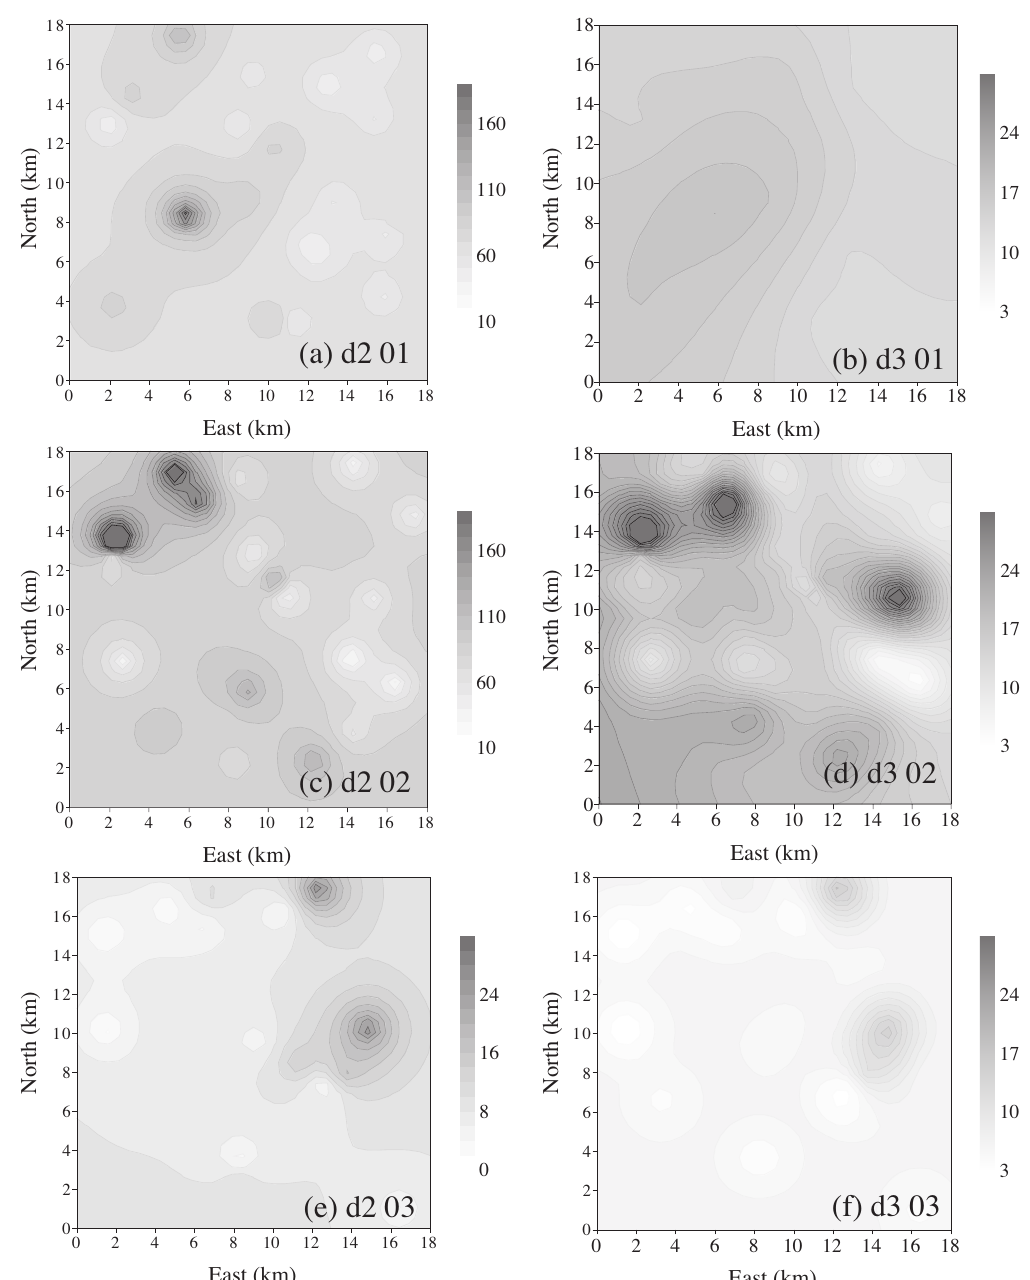
F IG . 6. – Density of dab biomass (cpue, kg 30 min -1 ) for size group d2 (a, c, e) and d3 (b, d, f) during cruises 2001-2003 (with star survey design) within box A. Estimations with ordinary kriging based on models fitted to annual structures. For d2 in 2001 and 2002 the model fitted to the generic semivariogram was used for